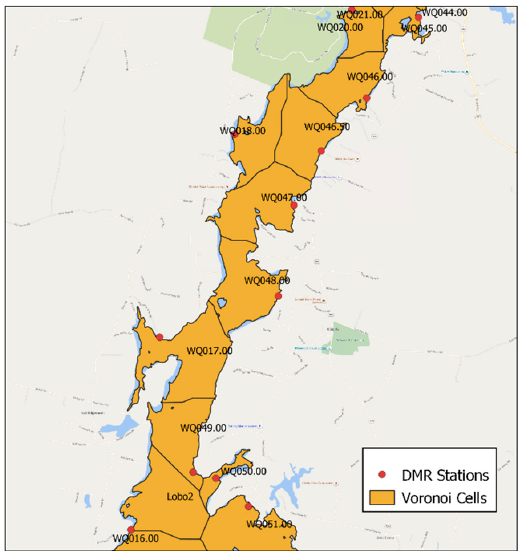
Figure 4. Voronoi cells generated from DMR monitoring stations plus LOBO buoy locations in the Damariscotta River Estuary. The labels are DMR station numbers represented by a concatenation of the Growing Area label and a station number. Each observation point captures water areas closer to it than any other point. Base map by Bing maps © 2020 Microsoft.